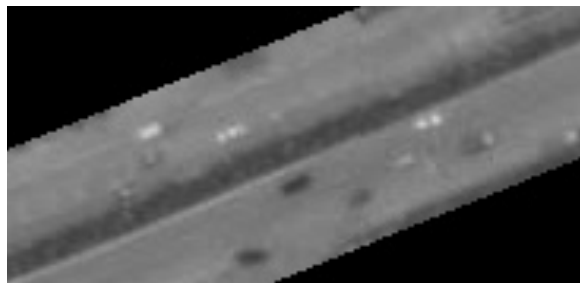
Figure 1: Road buffer